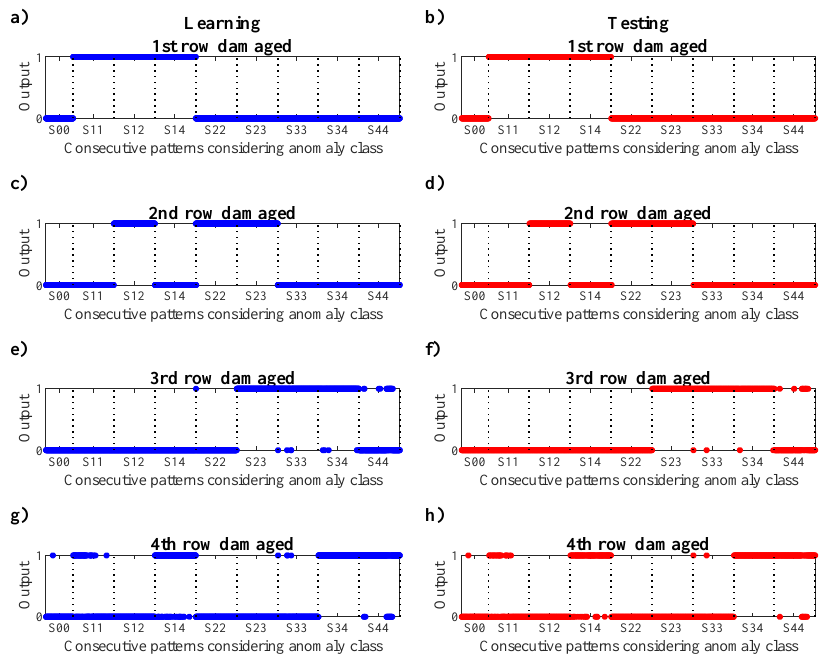
Figure 7. The results of anomaly detection for the networks of the second type with the architecture 6-35-4: ( a ) 1st row of bolts damaged, learning; ( b ) 1st row of bolts damaged, testing; ( c ) 2nd row of bolts damaged, learning; ( d ) 2nd row of bolts damaged, testing; ( e ) 3rd row of bolts damaged, learning; ( f ) 3rd row of bolts damaged, testing; ( g ) 4th row of bolts damaged, learning; ( h ) 4th row of bolts damaged, testing.